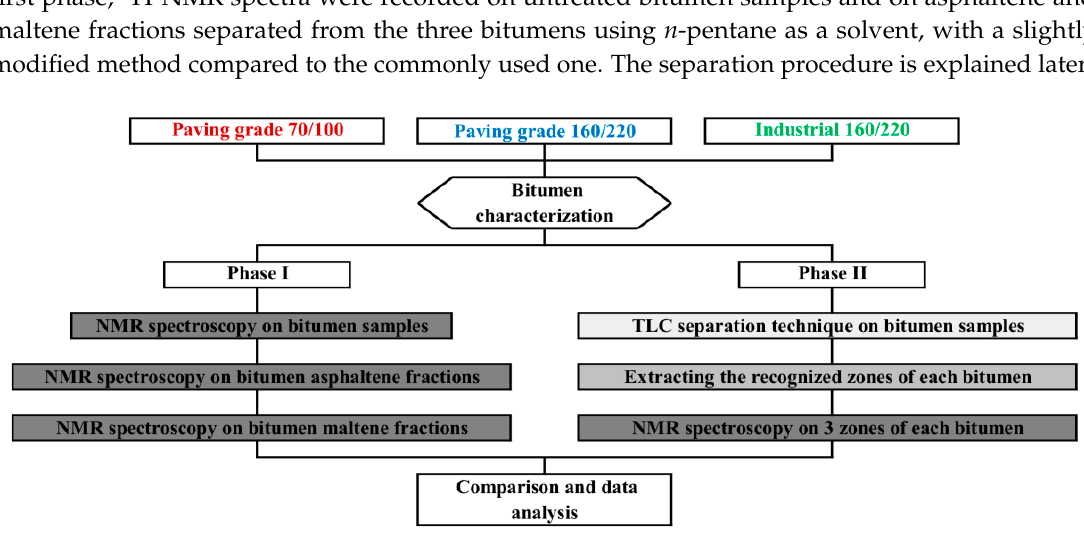
Figure 1. Research scheme.